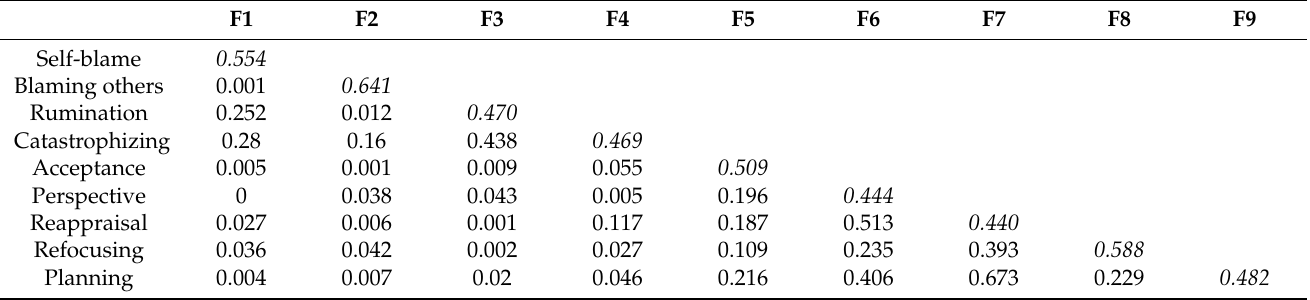
Table 5. Criterion of Fornell & Larcker